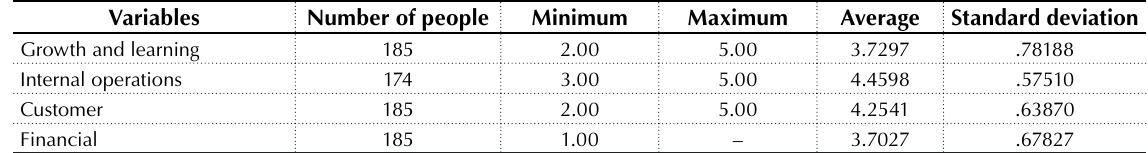
Table 2. Minimum, maximum, average and standard deviation of studied variables